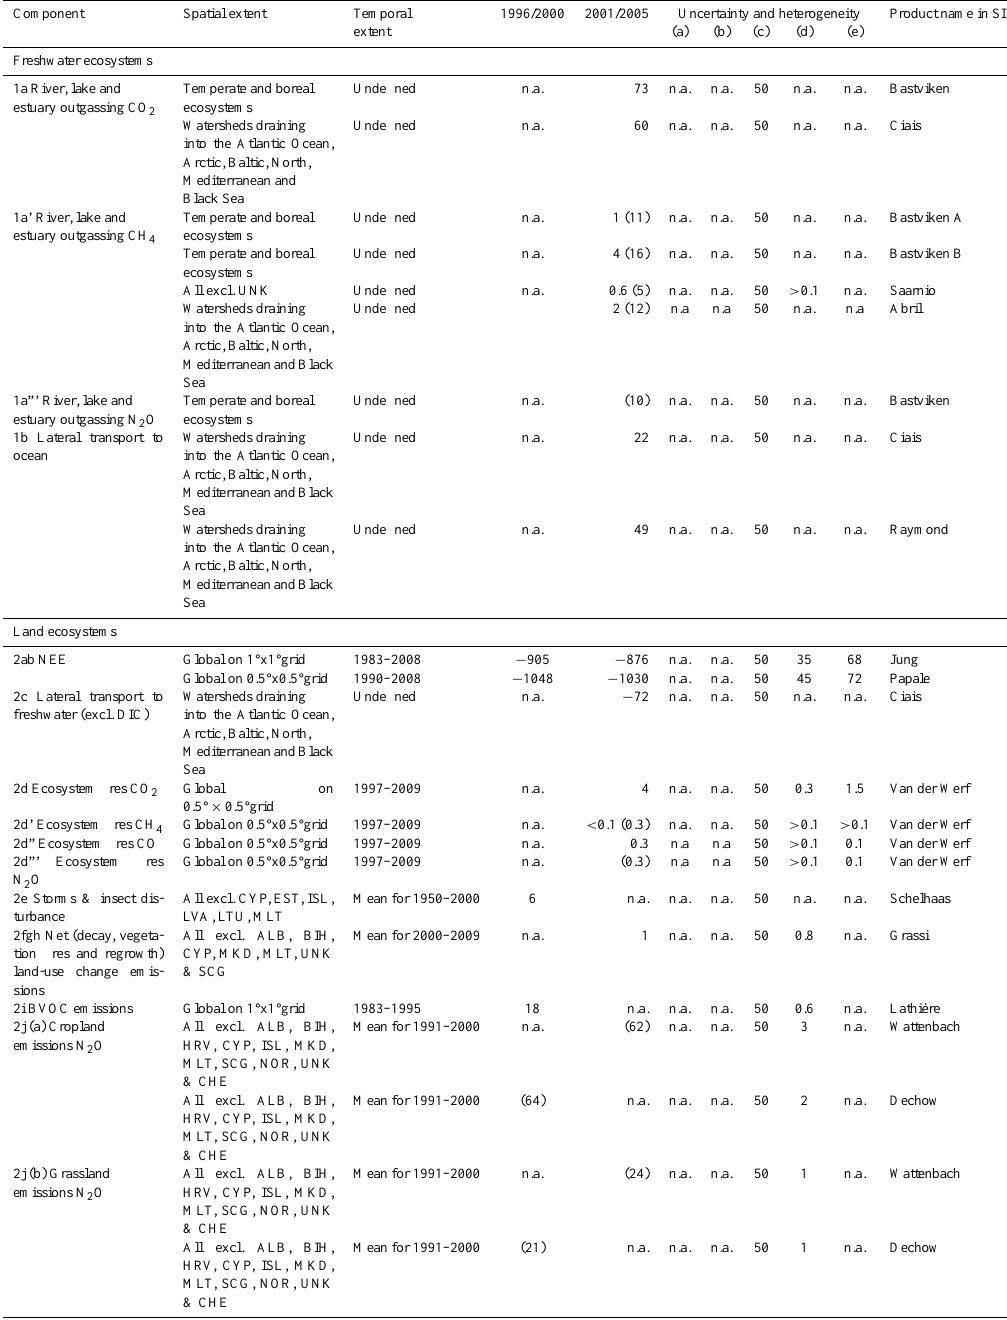
Table 1. Spatial and temporal extent of the component fluxes and stock changes of the European C and GHG balance. For the spatial extent, the ISO3166 country is used. Component fluxes are expressed in TgCyr − 1 for CO 2 , CO and CH 4 , TgCO 2 -eqCyr − 1 for CH 4 (global warming potential of 23 over 100yr; shown between brackets) and Tg CO 2 -eqCyr − 1 for N 2 O (global warming potential of 298 over 100yr; shown between brackets) for the periods 1996–2000 and 2001–2005. Estimates of the different sources of uncertainty and heterogeneity for the fluxes are expressed in TgCyr − 1 for CO 2 , CO and CH 4 and TgCO 2 -eqCyr − 1 N 2 O. The uncertainty and heterogeneity for the fluxes and stock changes are expressed in TgC. The following uncertainties and heterogeneities (defined in Sect. 2.5) are reported: (a) quasi-uniform range of likely model outputs derived from sensitivity analyses (standard deviation of a uniform distribution), (b) normally distributed uncertainty due to the set-up of the inversion model and is typically obtained through the Bayesian approach (standard deviation of a normal distribution), (c) expert estimate of the total uncertainty (%), (d) spatial heterogeneity (standard deviation of a normal distribution), (e) temporal heterogeneity (standard deviation of a normal distribution). The sources are further described in the Supplementary